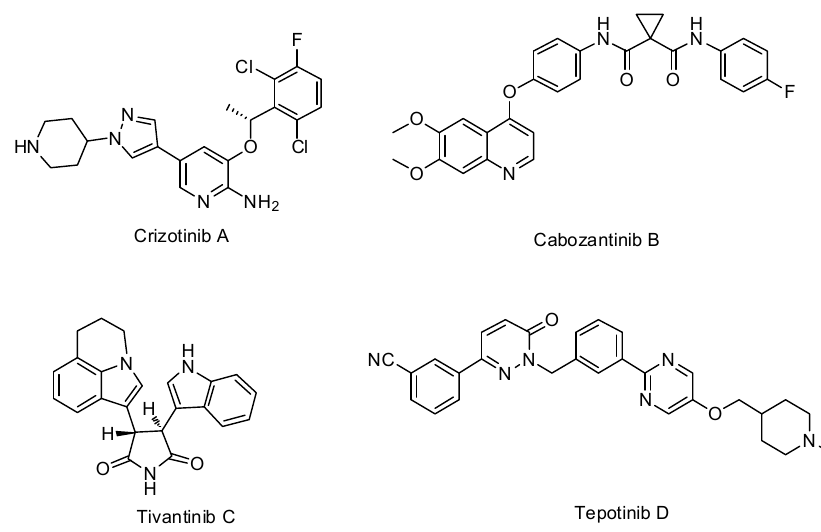
Figure 1. The representative c-Met kinase inhibitors of different structural types.